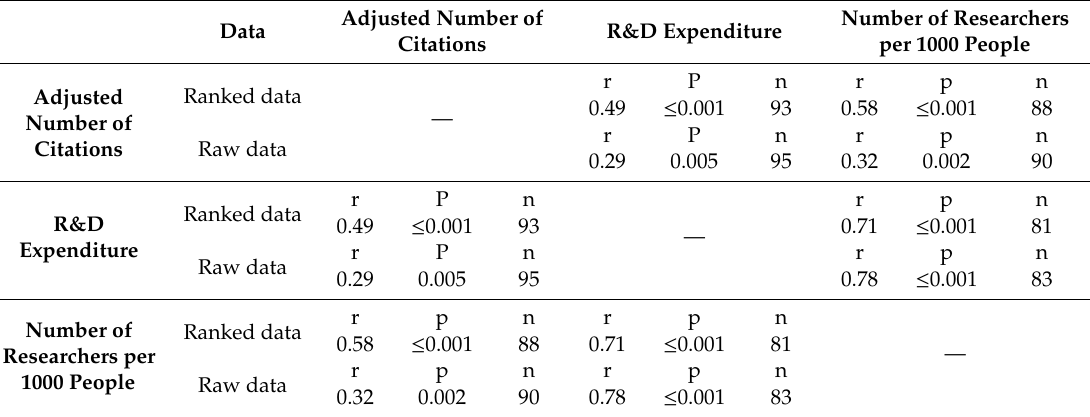
Table 1. Correlations between the adjusted number of citations per document and the R&D expenditure and number of researchers per 1000 people, using both ranked and raw data.